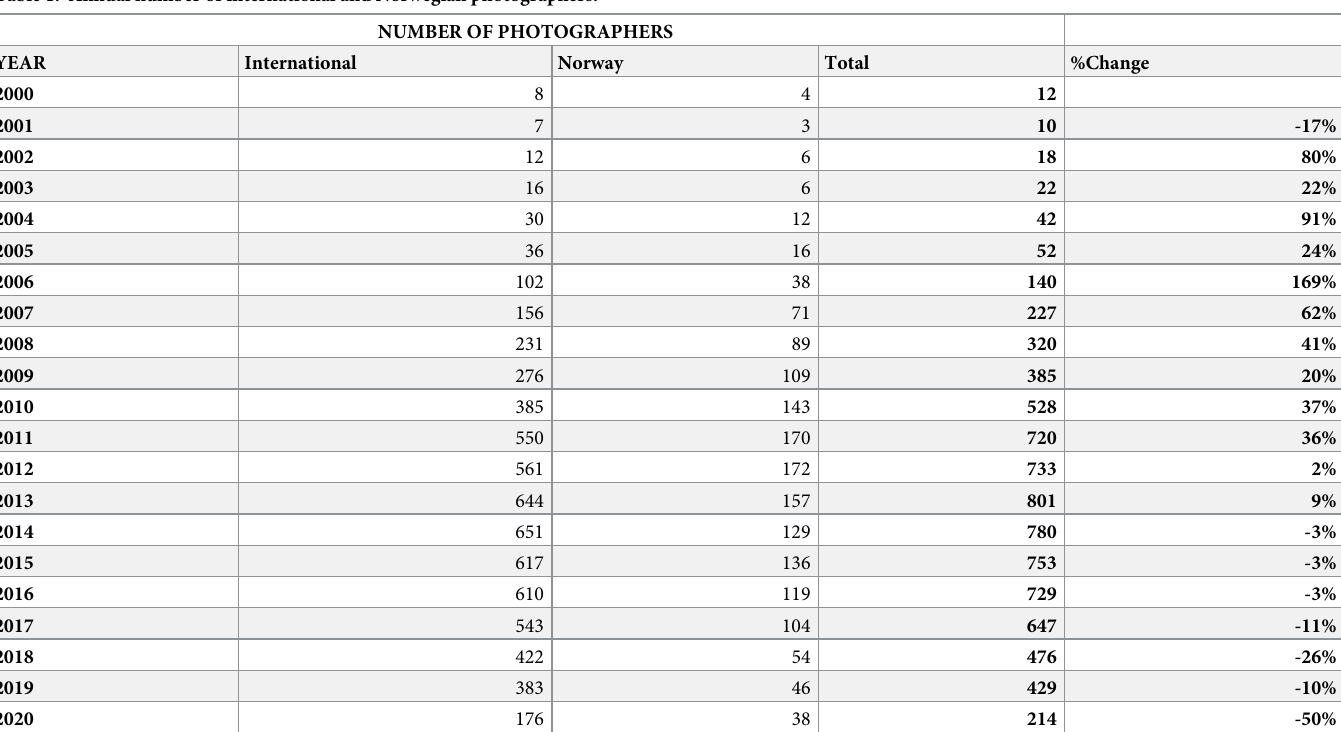
Table 1. Annual number of international and Norwegian